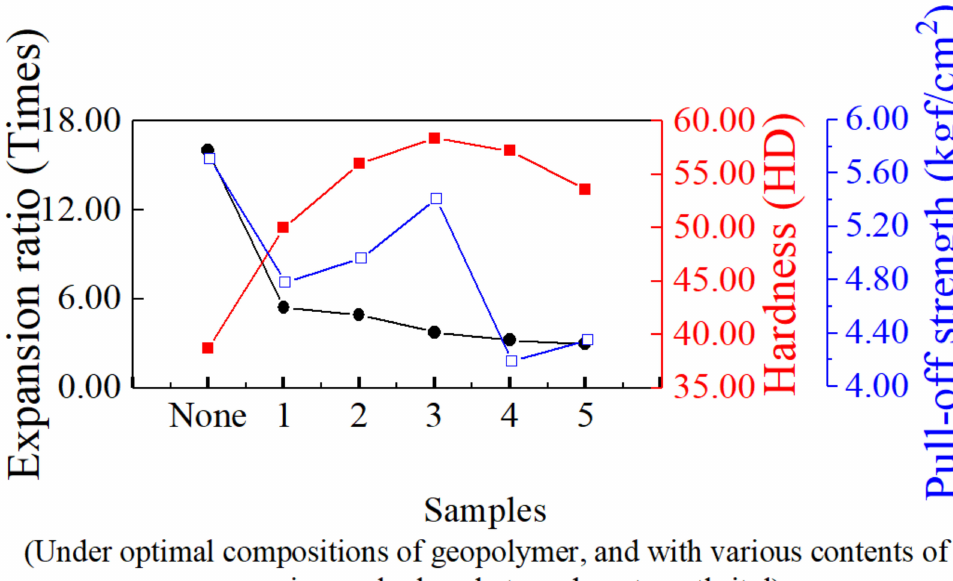
Figure 6. Physical properties of intumescent flame-resistance coatings containing optimal ratio of sodium silicate, ammonium polyphosphate and pentaerythritol after flame testing.